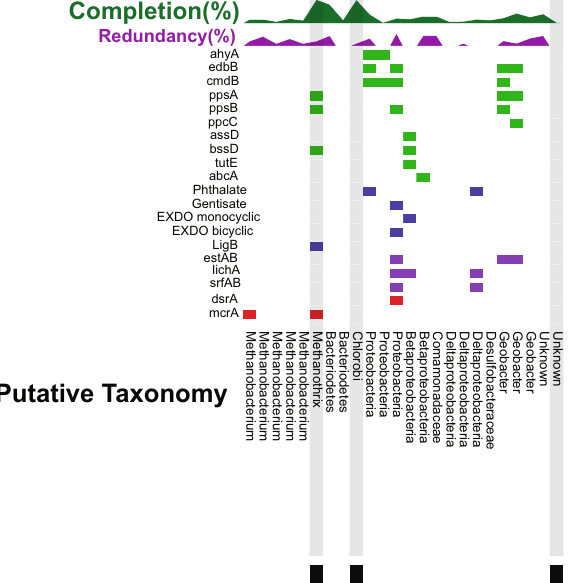
Fig. 4 Comparison of coverage and gene presence in BONCAT- positive metagenome-assembled genomes (MAGs). The presence of genes for each corresponding MAG is indicated with a color- coded box: anaerobic hydrocarbon degrading (green), aerobic hydrocarbon degrading (blue), biosurfactant (purple), and sulfate reduction/methanogenesis (red). The percent completion (green line graph out of 100%) and redundancy (purple line graph out of 10%) were compared for each MAG. The three highlighted MAGs with the symbol ( ■ ) have a >99% average nucleotide identity similarity to BONCAT-Total MAGs indicated with the same 4, Supplementary Fig. 2, Supplementary Data 4, Supplementary Data 5 and Supplementary Data 6). Bacteroidetes and Chlorobi